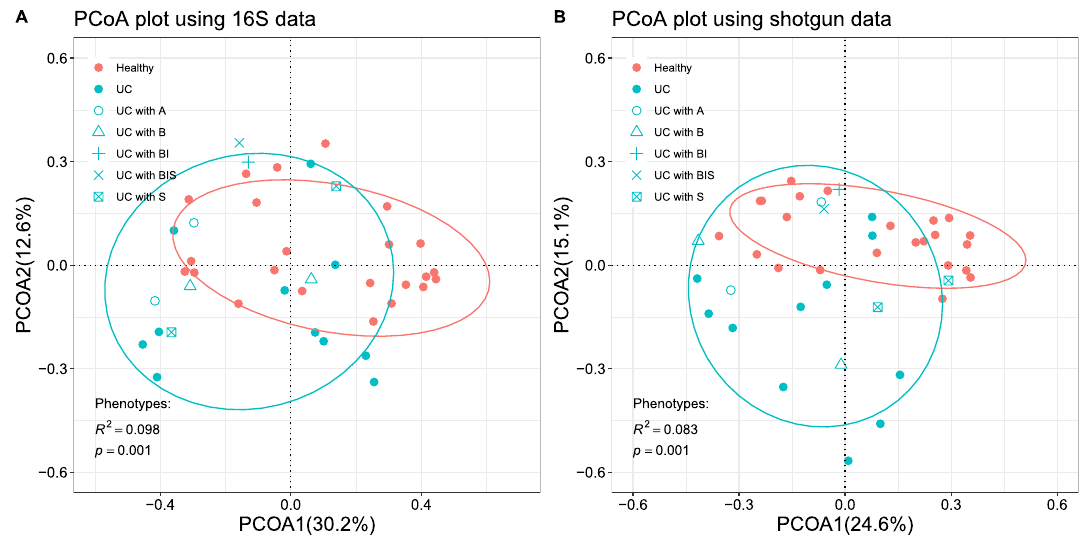
Figure 1. PCoA plots of the samples, with colors representing disease status and shapes representing therapies of UC patients ( A patients taking 5-aminosalicylates, B patients taking biologic therapy, I patients taking immunomodulators, S patients using steroid, BI both B and I). ( A ) PCoA based on Bray–Curtis distance calculated from the 16S rRNA genus level abundance profiles. ( B ) PCoA based on the Bray–Curtis distance calculated from the bacterial species level abundance using the shotgun reads